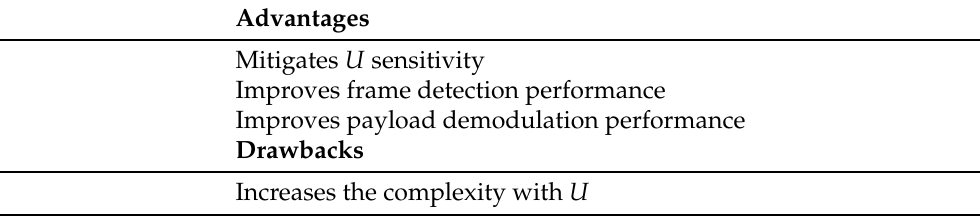
Table 4. Advantages and drawbacks of mod cross-corr.